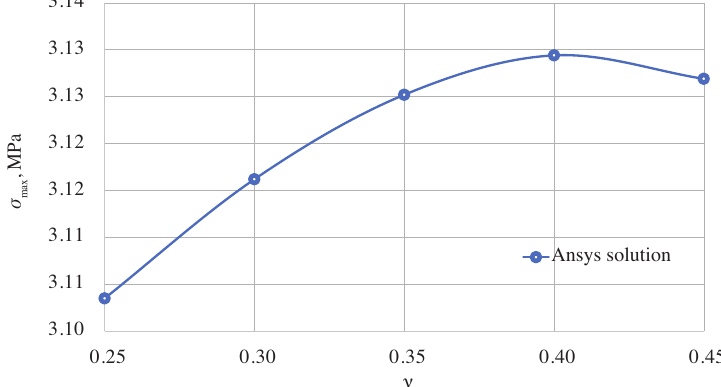
Figure 7. Variation of the subgrade Poisson’s